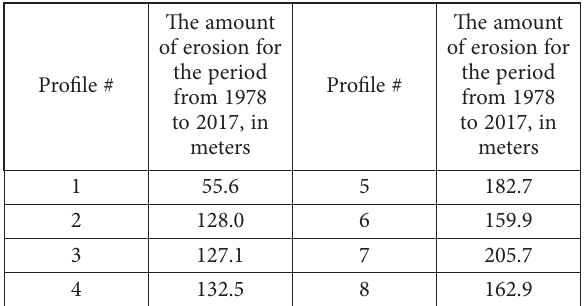
Table 2. Quantitative indicators of erosion of the Buktyrma